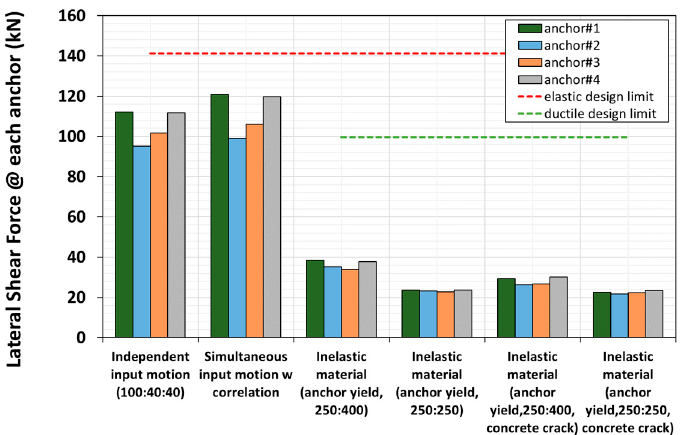
Figure 19. Anchor forces under shear (M24, pushover analyses).